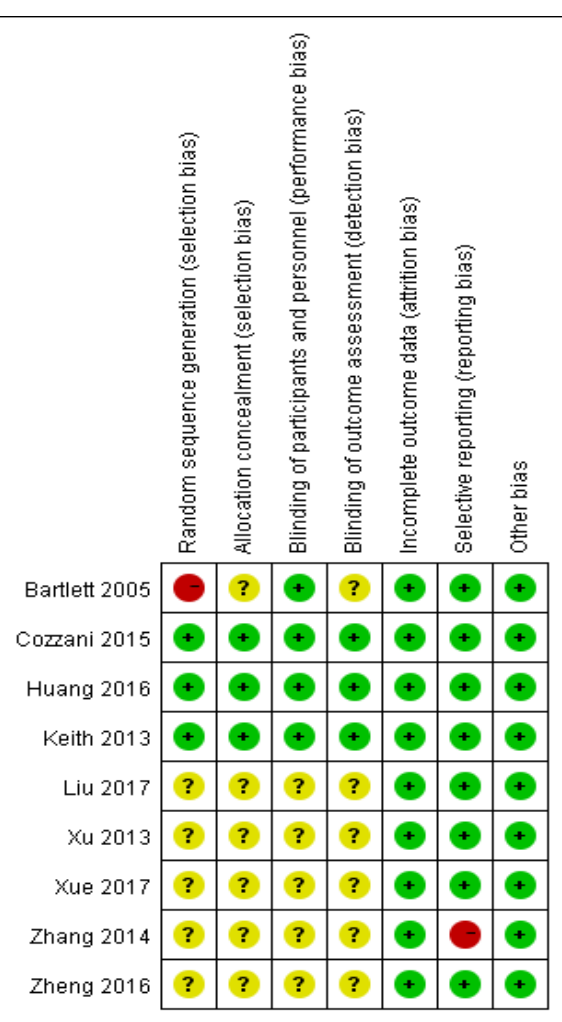
Figure 3. Risk of bias summary: review of the author’s judgment about each risk of bias item for each included